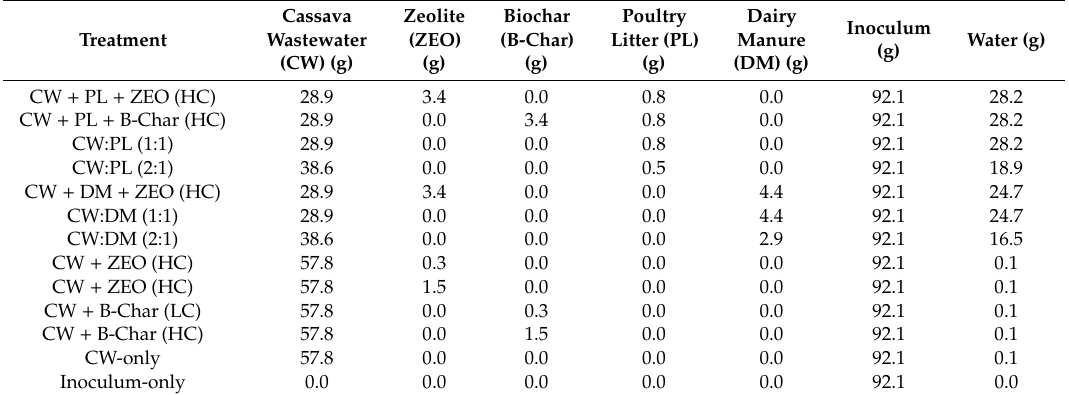
Table 1. Experimental design showing grams (g) of substrate addition into each triplicate 250 mL reactor.